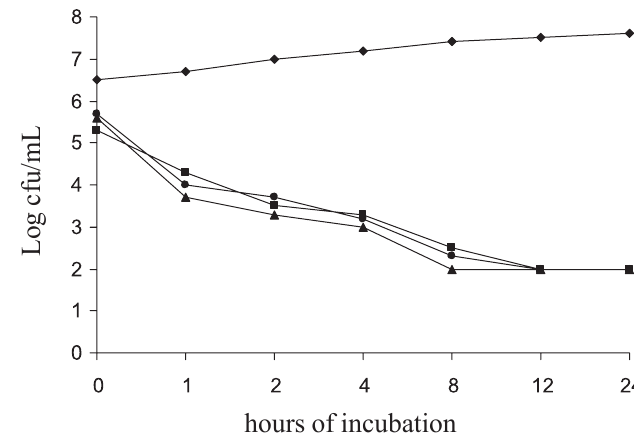
FIGURE 1 - Survivor curves for C. albicans ATCC 7645 in Sabouraud broth as a function of the antifungal compound: (  ): control (0 µL/mL); (  ): O. vulgare essential oil (80 µL/mL); (  ): O. majorana essential oil (160 µL/mL; (  ): ketoconazole (50 µg/mL). TABLE III - Sensitivity of potentially pathogenic fungi